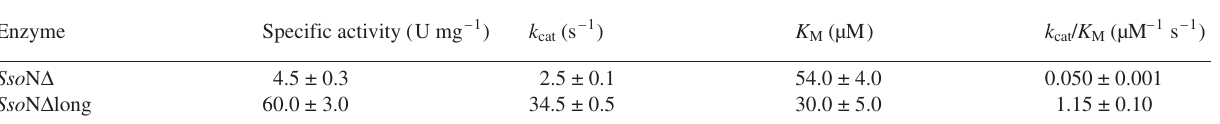
Table 1. Comparison of kinetic parameters of Sso N Δ and Sso N Δ long in their respective optimal conditions with the substrate pNP-hexanoate. As- says were done in duplicate or triplicate and the results shown are the means of two independent experiments. Enzyme